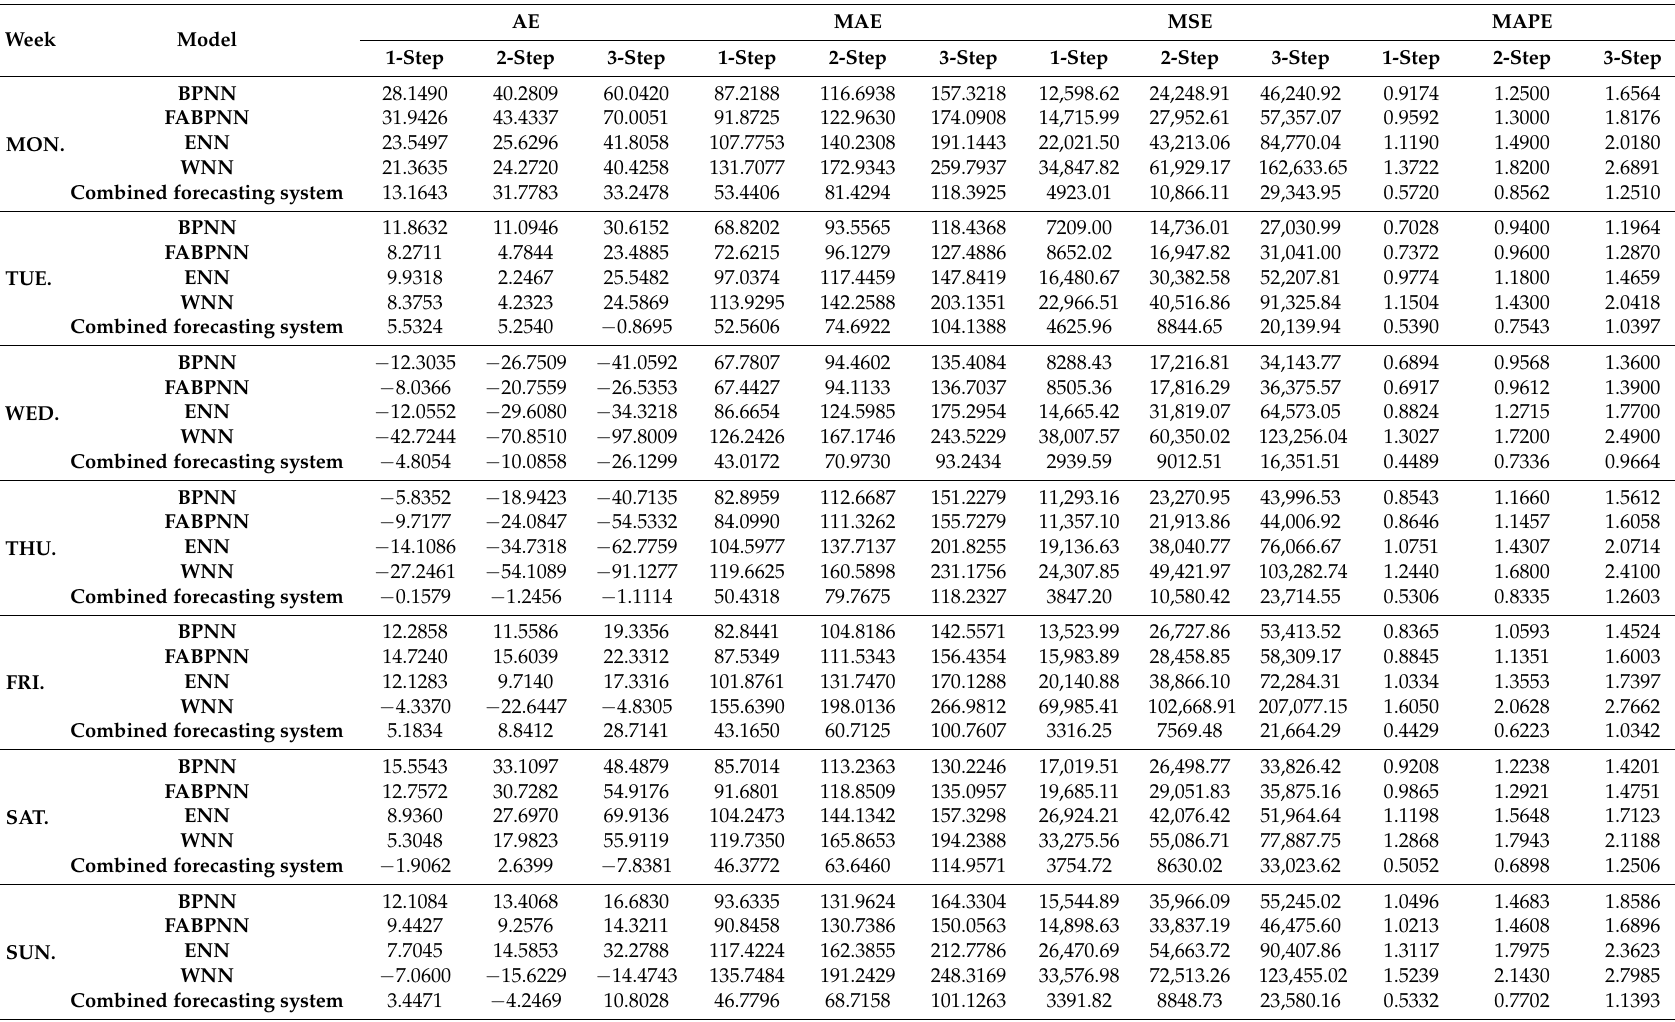
Table 7. Forecasting results obtained using June data from New South